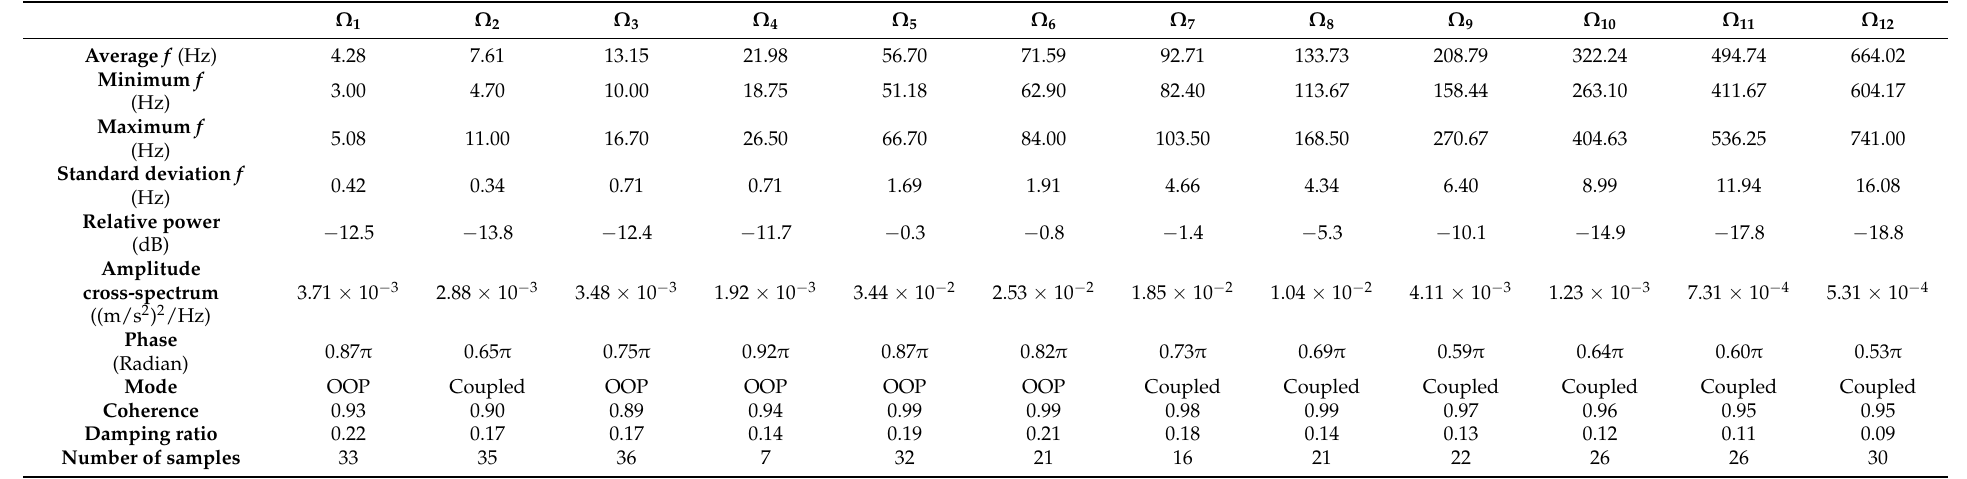
Table 4. Twelve modes and their associated modal and system